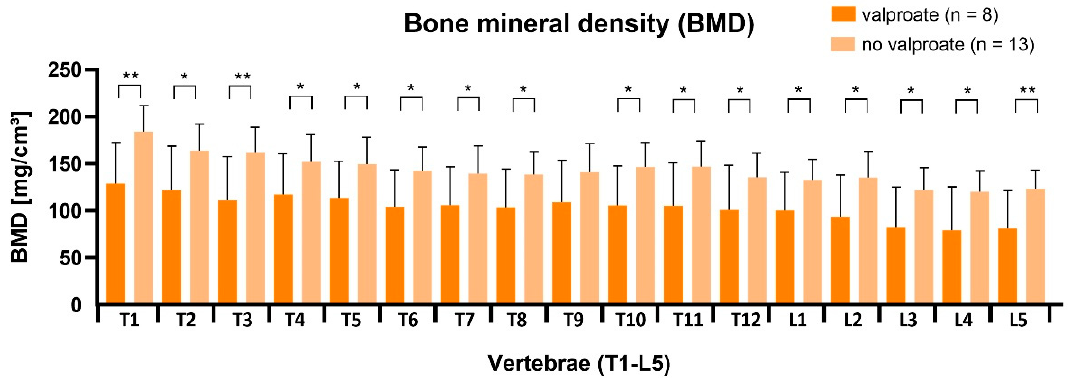
Figure 7. Significant vBMD reduction of almost all vertebrae in patients receiving valproate therapy, p < 0.05 (*) and p < 0.01 (**).